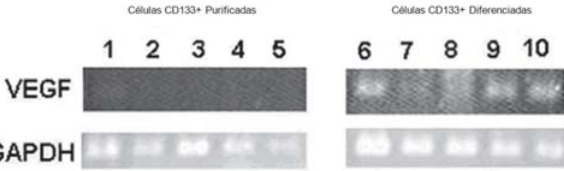
Fig. 2 - Gel de Agarose dos produtos de RT-PCR para o VEGF e GAPDH. Amostras 1 a 5: Células CD133+ purificadas; amostras 6 a 10: Células CD133+ diferenciadas